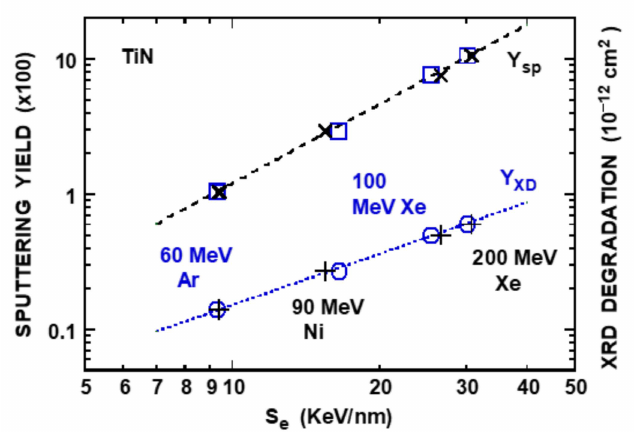
Figure 10. XRD intensity degradation Y XD (10 − 12 cm 2 ) (o, +) and sputtering yields Ysp (Ti + N) ( (cid:3) , x) vs. electronic stopping power S e (keV/nm). S e is calculated by TRIM1997 (o, (cid:3) ) and by SRIM2013 (+, x). Power-law fits are indicated by dotted lines: Y XD = (0.0224S e ) 1.26 and Y sp = (1.17S e ) 1.95